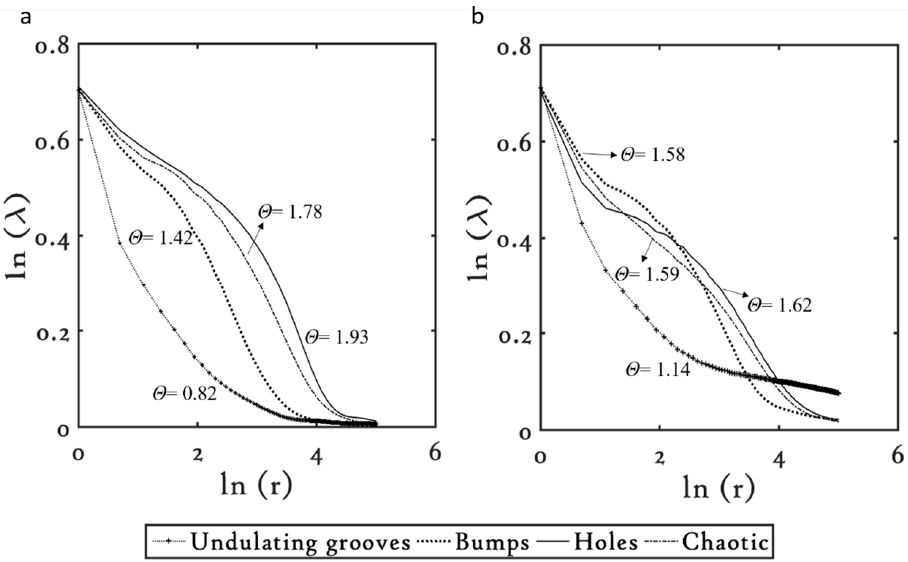
Figure 6. Lacunarity plots for the common microstructures on Ti at ( a ) 1 kHz and ( b ) 10 kHz. As the microstructures evolved with increasing (cid:1832) (cid:2954)(cid:3043)(cid:3048)(cid:3039)(cid:3046)(cid:3032) , their spatial heterogeneity increased, with undulating grooves being the least coarse, showing θ = 1.14, followed by the bumpy structures, showing θ = 1.58, and the holes, showing θ = 1.62. On further increasing (cid:1832) (cid:2954)(cid:3043)(cid:3048)(cid:3039)(cid:3046)(cid:3032) , the coarseness of the microstructure reduced, as observed in the chaotic structures, showing θ = 1.59. Comparison of the θ value for individual structures at the two repetition rates showed that the microstructures fabricated at lower (cid:1832) (cid:2954)(cid:3043)(cid:3048)(cid:3039)(cid:3046)(cid:3032) values are coarser when micromachined at 10 kHz. For instance, the undulating grooves and the bumpy microstructures that are machined at lower (cid:1832) (cid:2954)(cid:3043)(cid:3048)(cid:3039)(cid:3046)(cid:3032) values (see Table 3) appear coarser at 10 kHz. As (cid:1832) (cid:2954)(cid:3043)(cid:3048)(cid:3039)(cid:3046)(cid:3032) is increased and the high (cid:1832) (cid:2954)(cid:3043)(cid:3048)(cid:3039)(cid:3046)(cid:3032) regime is reached, where for instance the holes and the chaotic microstructures were fabricated, the microstructures appear coarser when fabricated at 1 kHz. Alternatively, with an increase in the (cid:1832) (cid:2954)(cid:3043)(cid:3048)(cid:3039)(cid:3046)(cid:3032) values, the lacunarity of the microstructures at 10 kHz was observed to reduce in comparison to their counterparts fabricated at 1 kHz. Overall, the behavior in the lacunarity of the microstructures on Ti was very similar to what we observed on Cu; with increasing (cid:1832) (cid:2954)(cid:3043)(cid:3048)(cid:3039)(cid:3046)(cid:3032) , the lacunarity of the microstructures at 10 kHz reduces and becomes lower than their counterparts at 1 kHz.